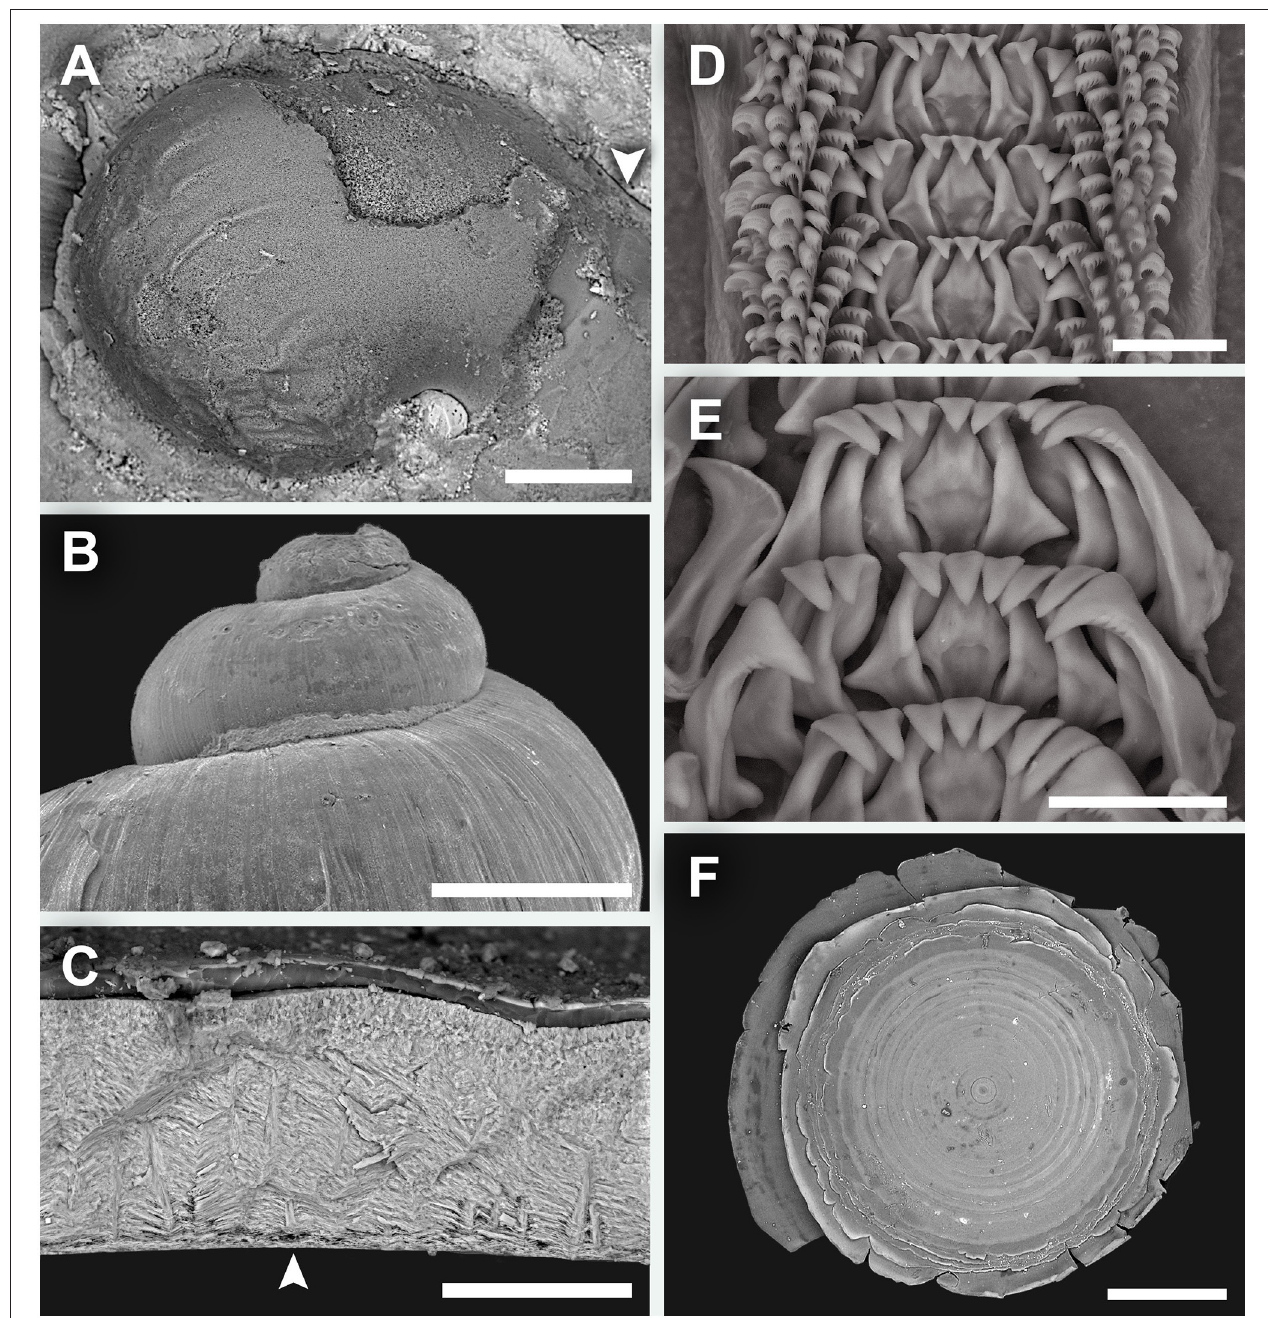
FIGURE 3 | Lirapex politus n. sp. scanning electron micrographs. (A) Protoconch, (B) Shell surface of the upper half of the shell, as seen from the abapertural view, (C) Shell microstructure, (D) Radula, (E) Close-up of central and lateral teeth, (F) Operculum. Scale bars: (A) 50 µ m, (B) 1mm, (C) 50 µ m, (D–E) 25 µ m, (F) 0.5mm. contracted, conical and gradually decrease in size